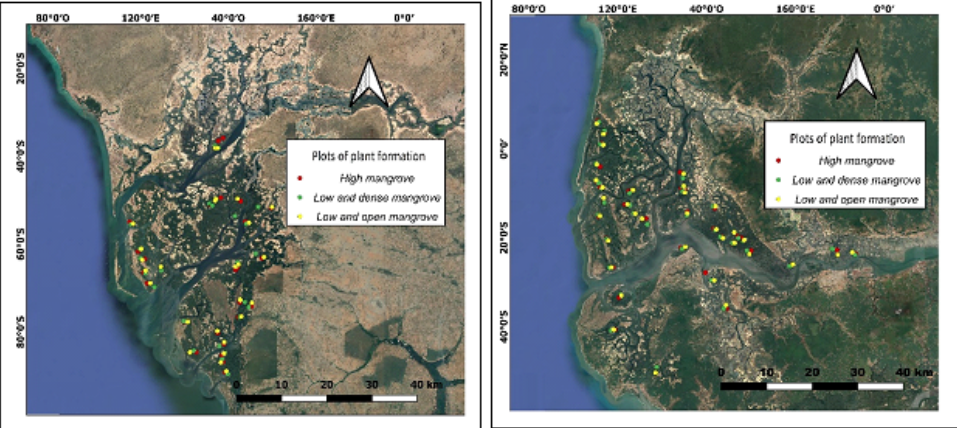
Figure 4. Distribution of the validation samples for the mangrove zonation classification ( left : Saloum; right : Casamance).